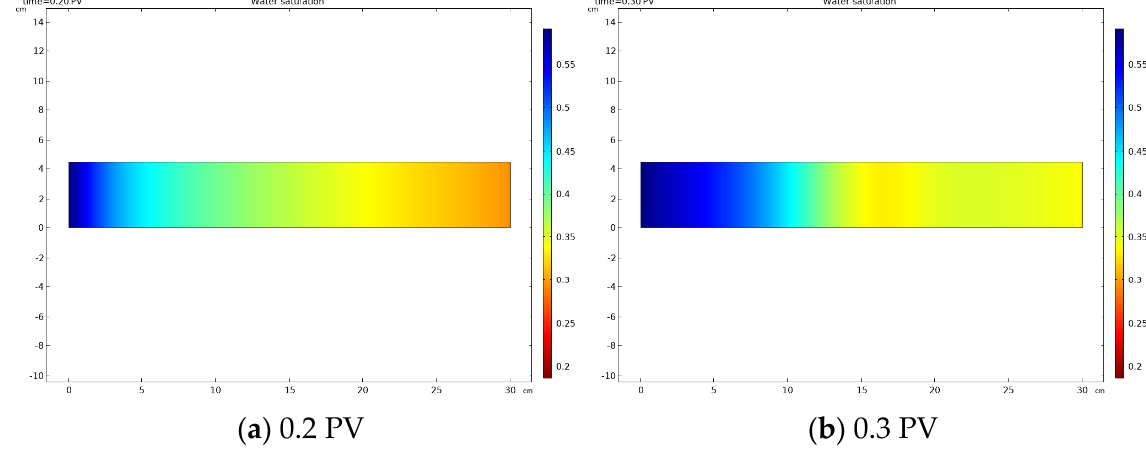
Figure 13. Water saturation at different injection times when water − oil viscosity ratio is 0.1.